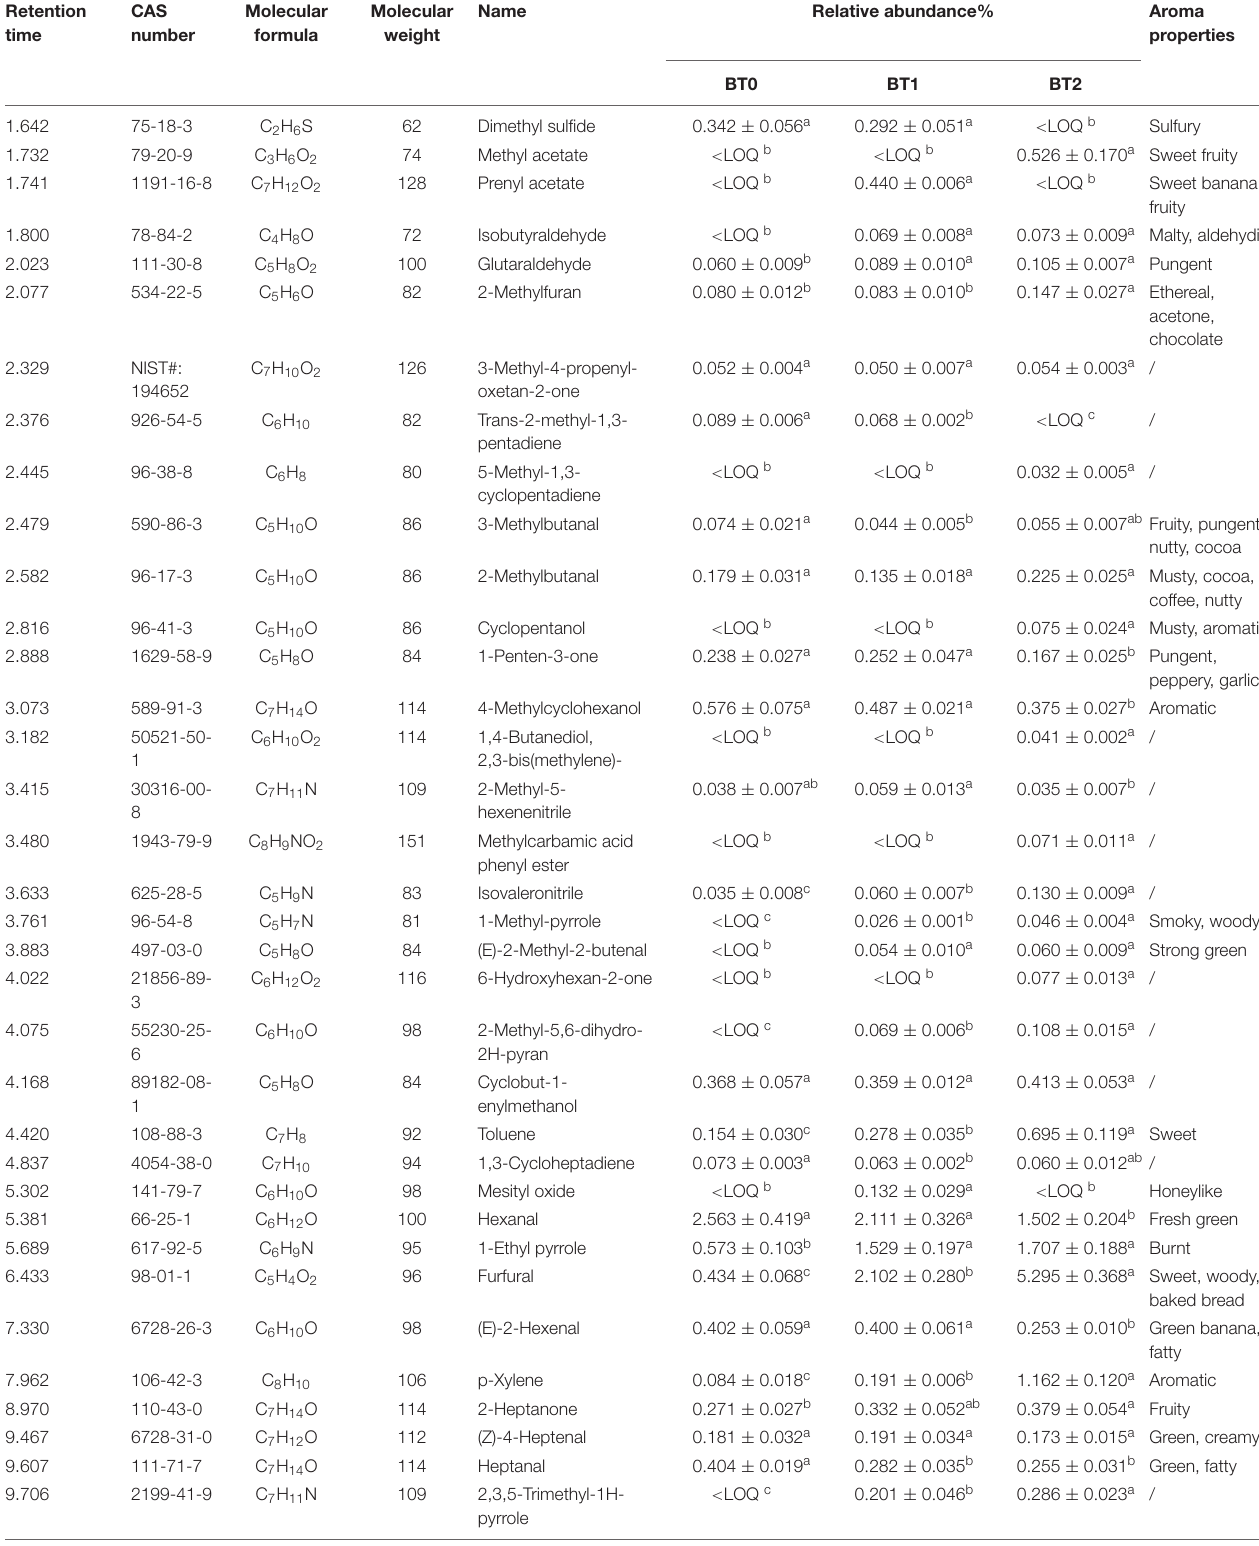
TABLE 4 | Volatile compounds in jade (BT0), medium-baked (BT1), and deep-baked (BT2) Tieguanyin oolong teas determined by GC-MS. Retention